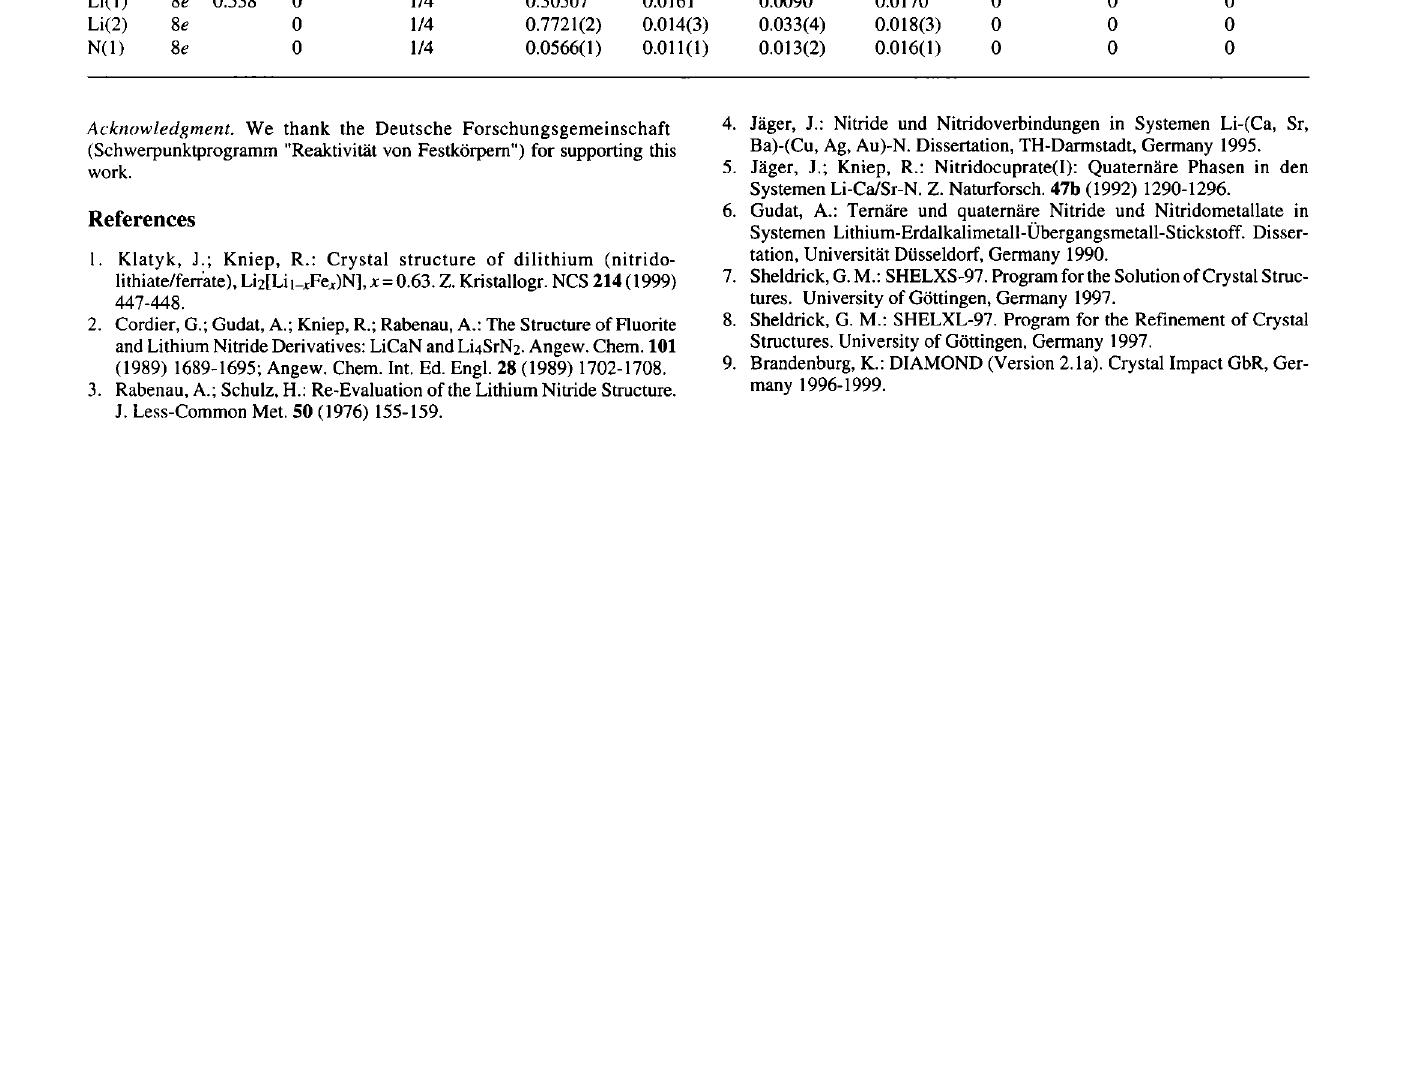
Table 4. Atomic coordinates and displacement parameters (in Ä 2 ). Atom Site